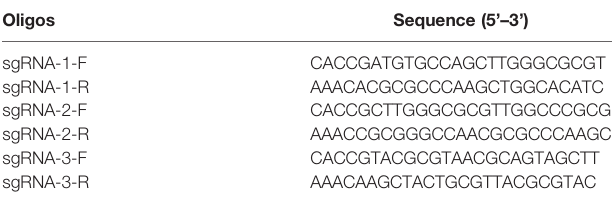
TABLE 2 | The targeting sgRNA oligo